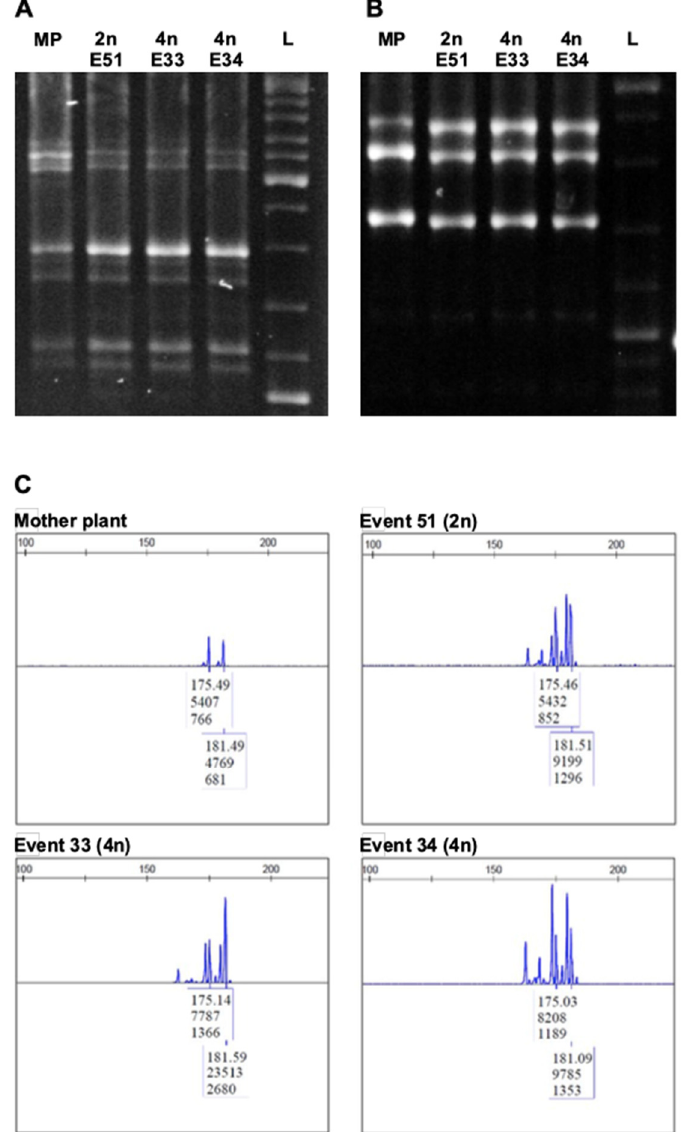
Figure 3. Genetic fidelity assessment of diploid (event 51) and tetraploid (events 33 and 34) ‘Frappato’ regenerants with ISSR markers. Profiles were obtained with: ( A ) Primer ISSR1-6; L, ladder Thermo Scientific™ GeneRuler™ DNA Ladder Mix; MP, mother plant; E51, event 51 (2n); E33, event 33 (4n); E34, event 34 (4n). ( B ) Primer ISSR2 + 2b. L, ladder Thermo Scientific™ GeneRuler™ DNA Ladder Mix; MP, mother plant; E51, event 51 (2n); E33, event 33 (4n); E34, event 34 (4n).